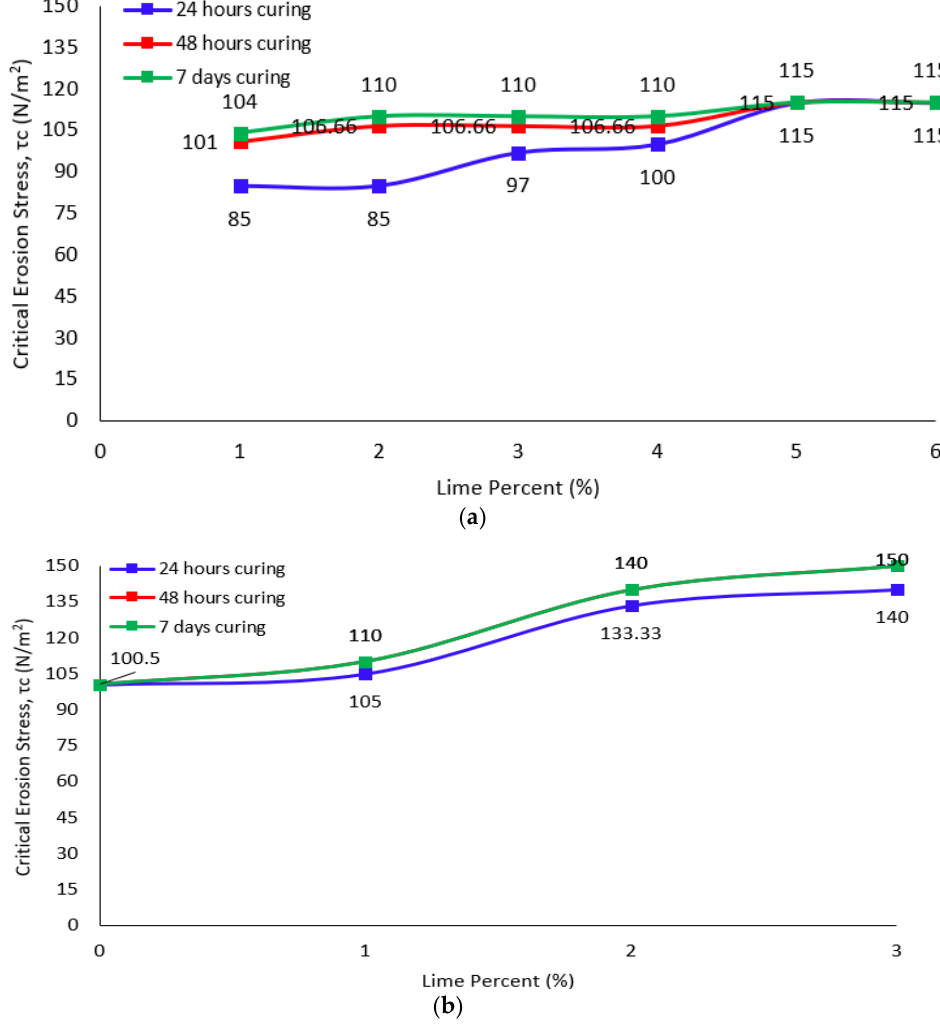
Figure 4. Critical erosion stress ( τ c ) versus lime percent (%) for ( a ) Soil #1 and ( b ) Soil #2 with various curing times.